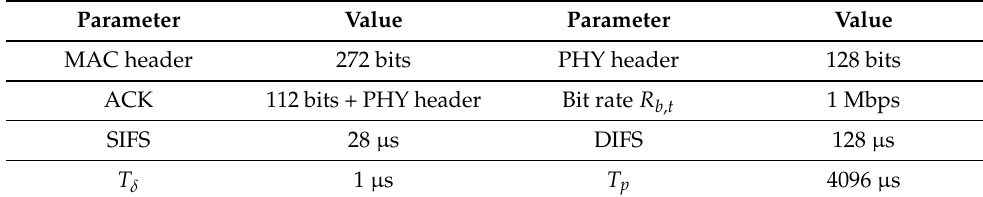
Table 1. MAC network